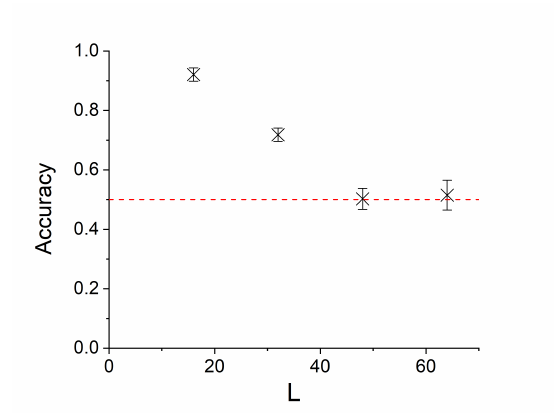
Figure 10: The accuracy of the ANN output decreases when the coarse-graining scale significantly differs from the training set. The parameters of the tight-binding models are identical to those in the main text and summarized in Appendix A and the system sizes are L × L with L = 16,32,48,64, respectively. The LDOS data is then reduced to a 16 × 16 field of view and, in turn, assessed by the